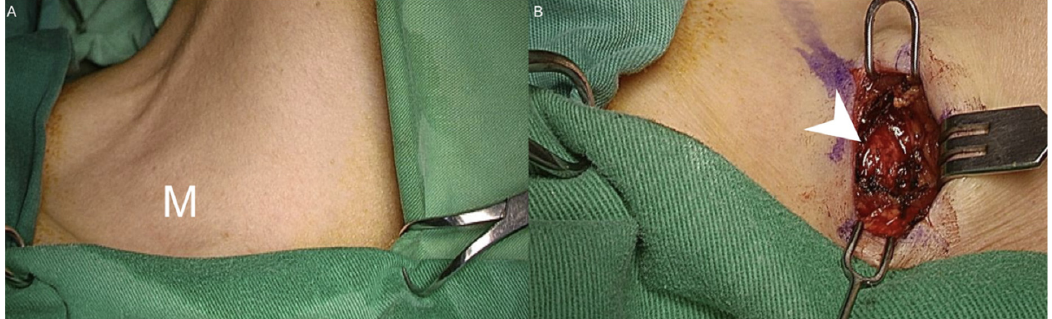
Figure 3. ( A ) A well ‐ defined and fixed mass was noted in the right neck level V area. No erythematous change or local heat over the skin was observed. (M: mass); ( B ) the incision was made above the mass. The left neck mass (arrowhead) was explored and en bloc resection was conducted.